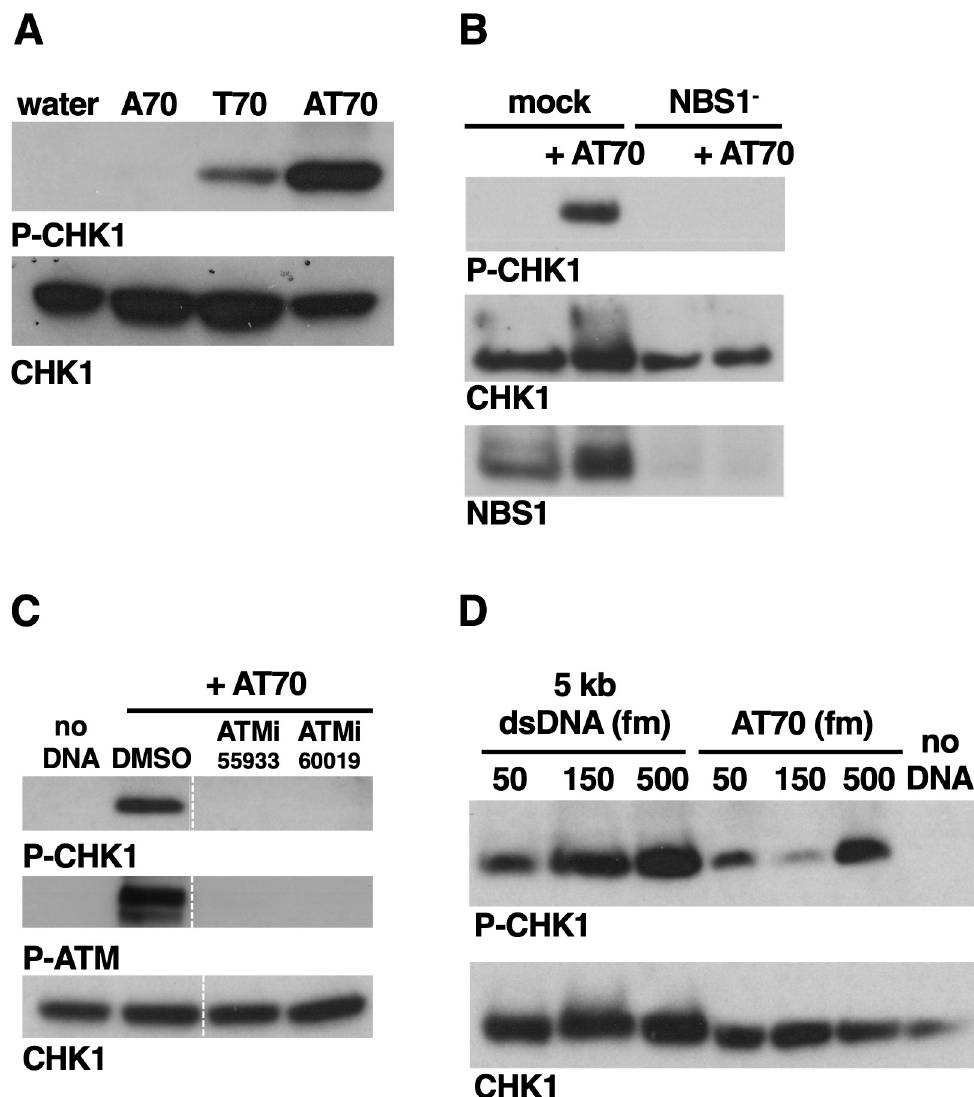
Fig 6. The AT70 DNA structure requires MRN and ATM for ATR signaling. A. XEEs were incubated with either water, the A70 oligonucleotide, the T70 oligonucleotide, or the two oligonucleotides that had been annealed together (AT70). The samples were then probed for P-CHK1 and CHK1. The experiment shown is representative of two independently performed biological replicates. B. AT70 was optionally added to either mock- or NBS1-depleted extract. After incubation, samples were pulled and probed for the indicated proteins. The experiment shown is representative of two independently performed biological replicates. C. Extracts were treated with the indicated compounds and AT70 was optionally added. After incubation, samples were pulled and probed for the indicated proteins. ATMis were present at 100 uM. The experiment shown is representative of two independently performed biological replicates. D. The indicated DNAs at the indicated concentrations were added to XEEs and, after incubation, samples were pulled and probed for the indicated proteins. The experiment shown is representative of two independently performed biological